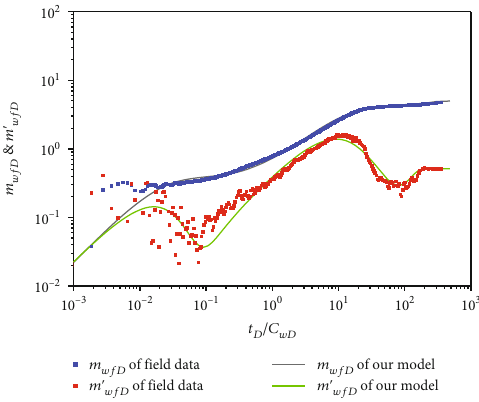
Figure 15: Typical curve match of the fi eld data.